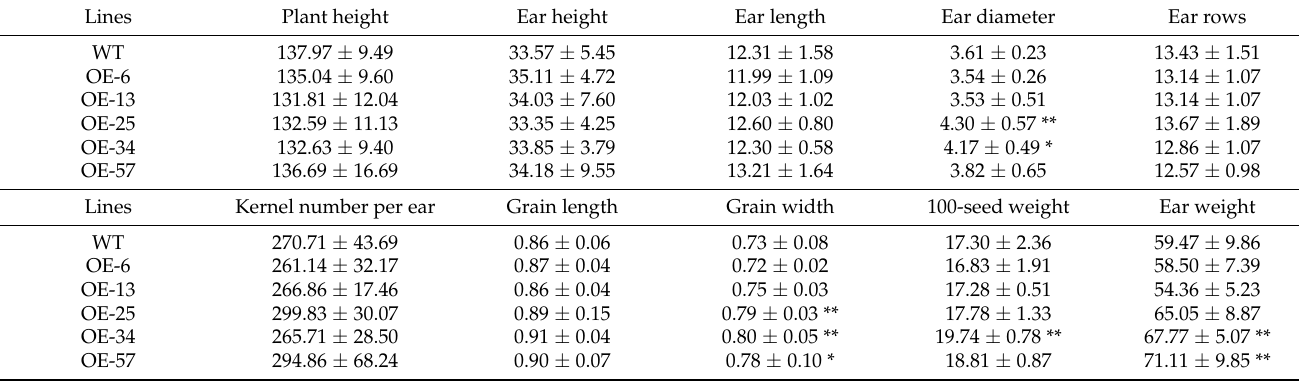
Table 1. Agronomic traits of T 3 -generation GS5 transgenic maize.